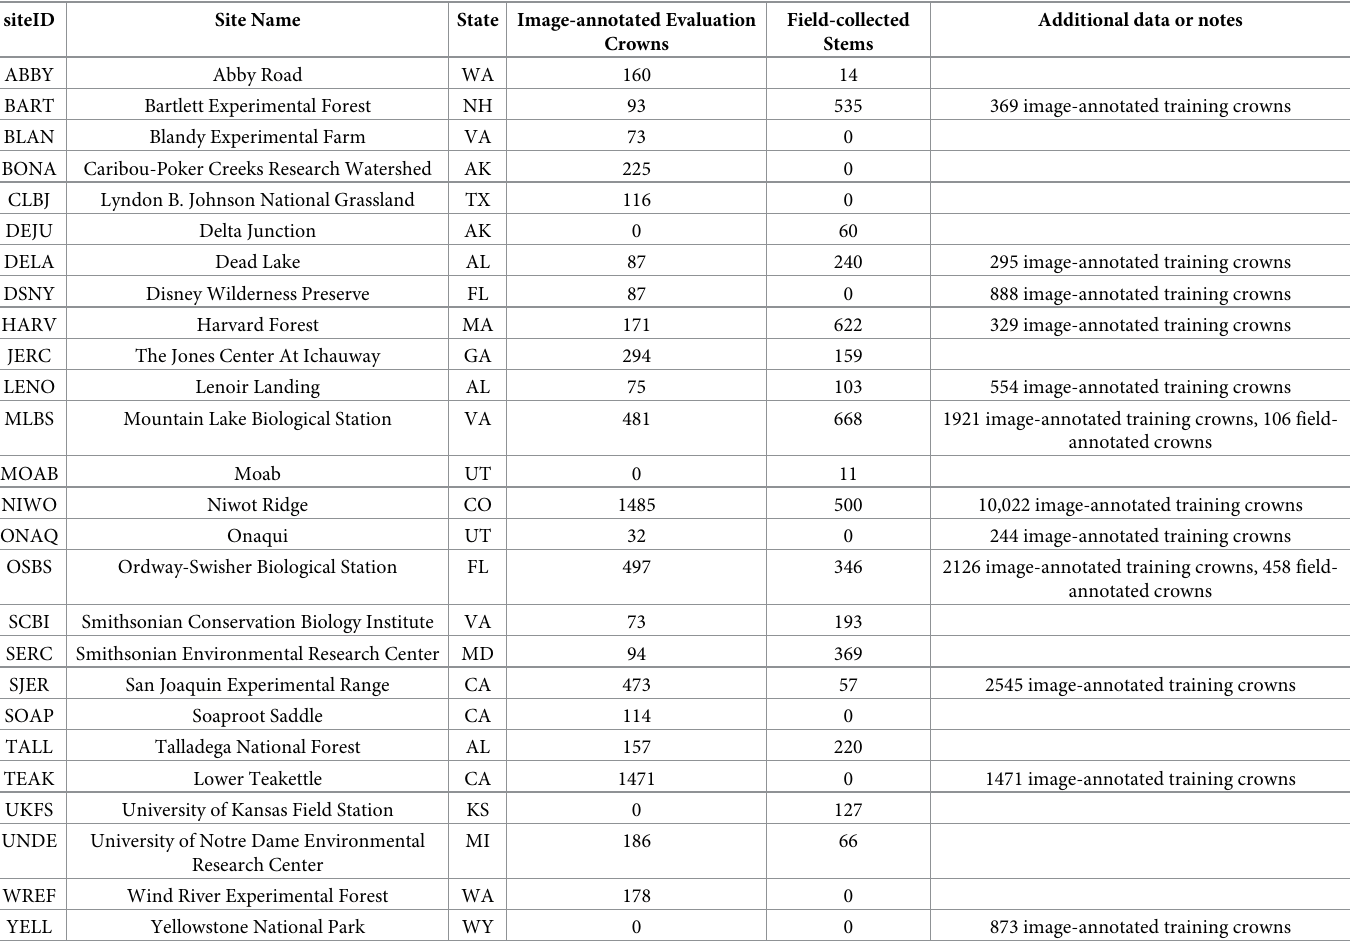
Table 2. Annotations for each data type for each of the NEON